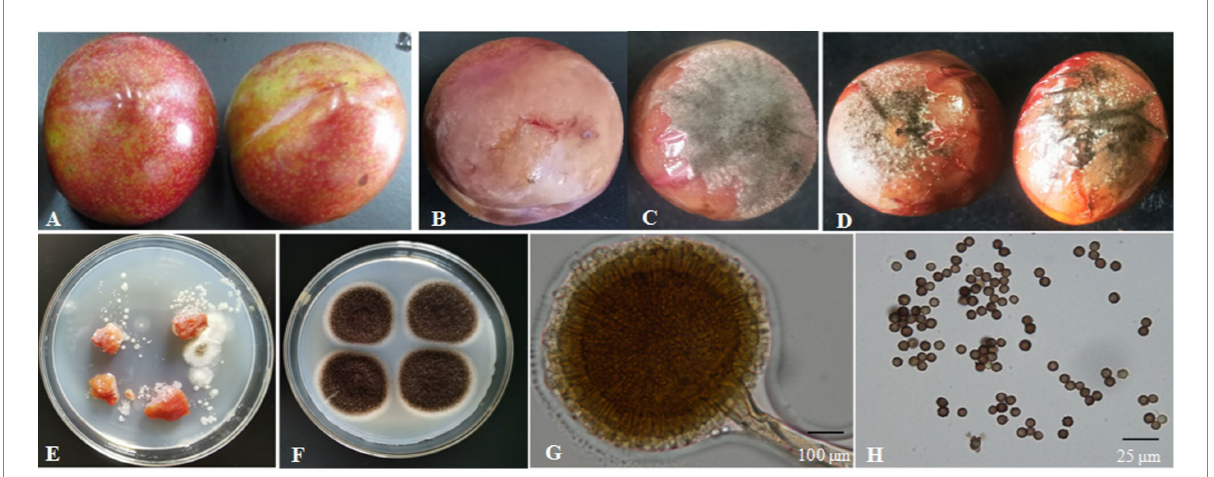
FIGURE 3 Isolation of the fungal strain from naturally infected fruit. (A) Healthy fruit; (B,C) naturally infected fruit; (D) fruit 4 days after inoculation with fungi for 4 days; (E) fungi isolated from naturally infected fruit; (F) fungi colony cultured for 4 days on PDA; (G) conidium and sporangium, 200×, bar = 100 μ m; (H) spore, 1,000×, bar = 25 μ